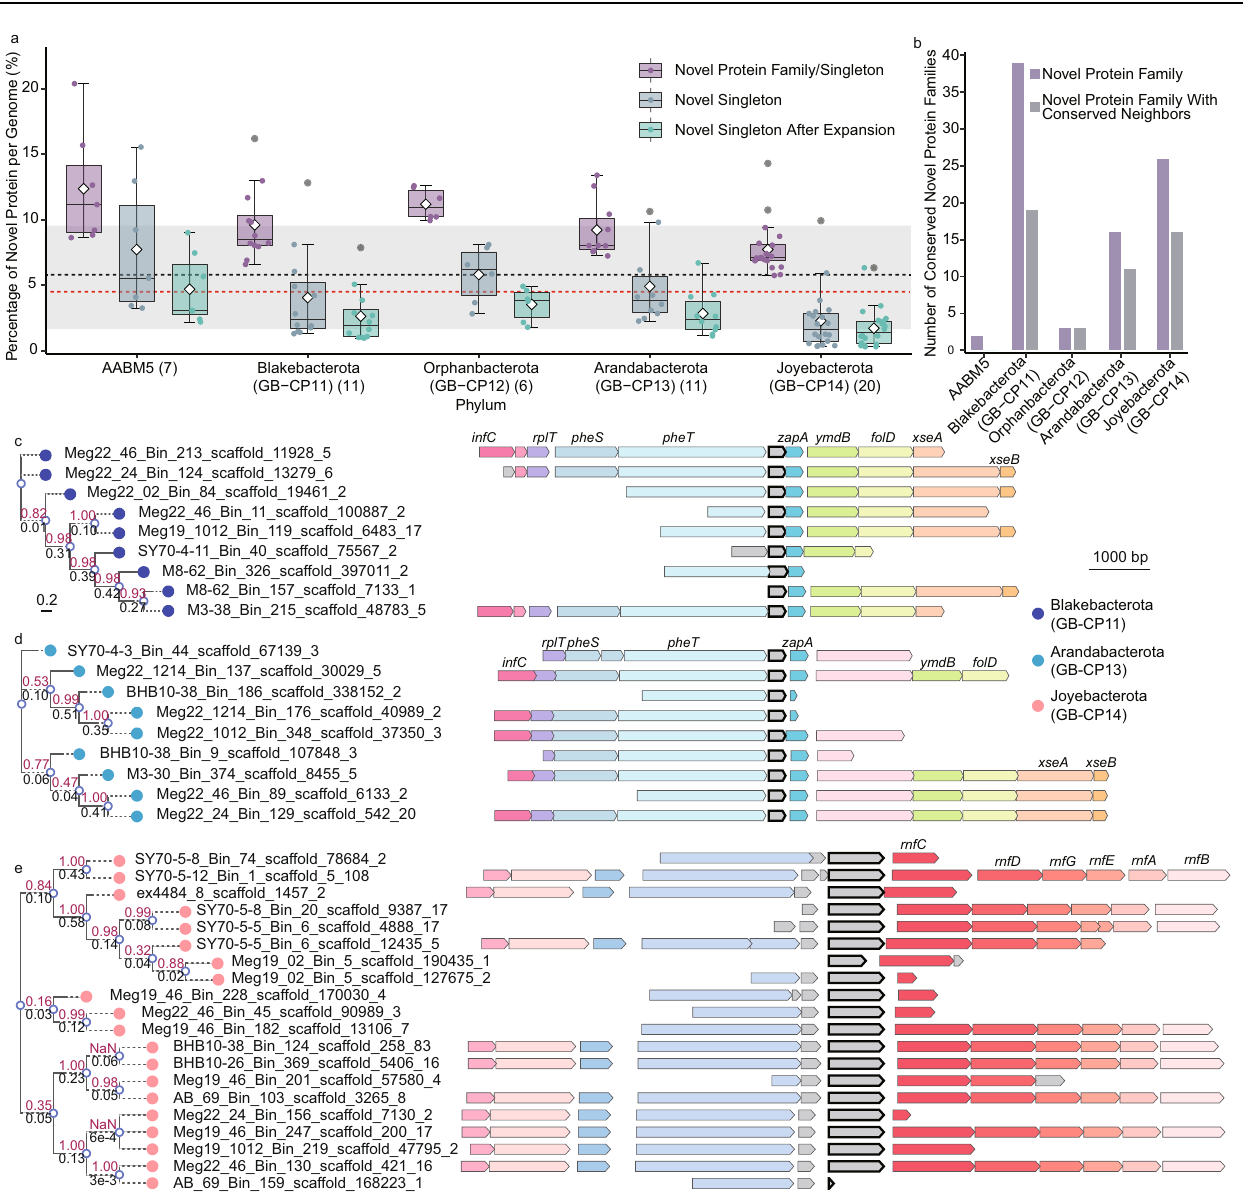
purple bars. The number of novel protein families with conserved neighboring genes are shown in light gray bars. c , d , Selected examples of phylogenetic trees and novel protein family genomic context marked in gray with a black outline) in Blakebacterota and Arandabacterota. The protein families are similar between these two phyla and have conserved neighboring genes, including translation initiation factor IF-3 gene ( infC ), large subunit ribosomal protein L20 gene ( rplT ), phenylalanyl-tRNA synthetase genes ( pheST ), cell division protein gene ( zapA ), phosphodiesterase gene ( ymdB ), methenyltetrahydrofolate cyclohydrolase gene ( folD ), and exodeoxyribonuclease genes ( xseAB ). e Phylogenetic tree and genomic context of a novel protein family uniquely distributed in Joyebacterota. The novel protein family has conserved genomic neighbors related to energy conservation (Rnf complex genes, rnfABCDEG ). The phylogeny was generated using FastTree2 and numbers on the top and bottom of the branch represent the bootstrap and branch length, respectively. Source data are provided as a Source Data fi